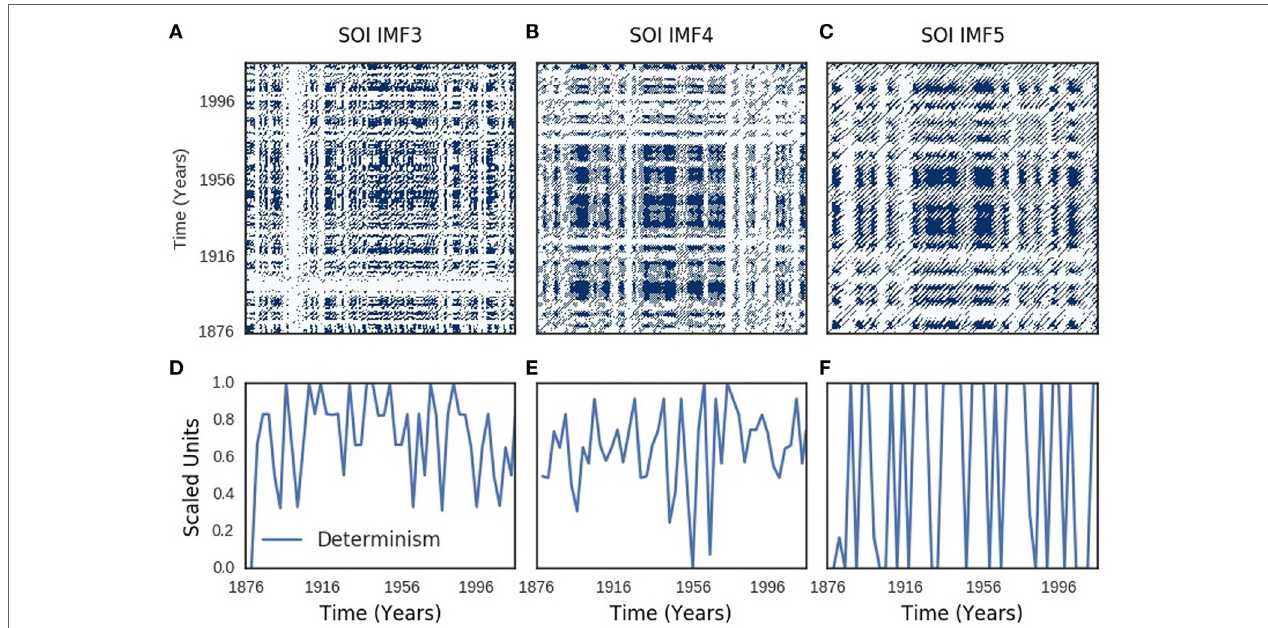
FigUre 4 | Southern oscillation (SOI) recurrence plots. Recurrence plots shown in (a–c) resemble Lorenz chaotic dynamics. Periodic regimes have long, uninterrupted, even parallel diagonal lines, while quasi-periodic regimes have uneven vertical distances between the diagonal lines. Chaotic regimes have single points and short diagonal lines. Time-varying determinism is shown in (D–F) .